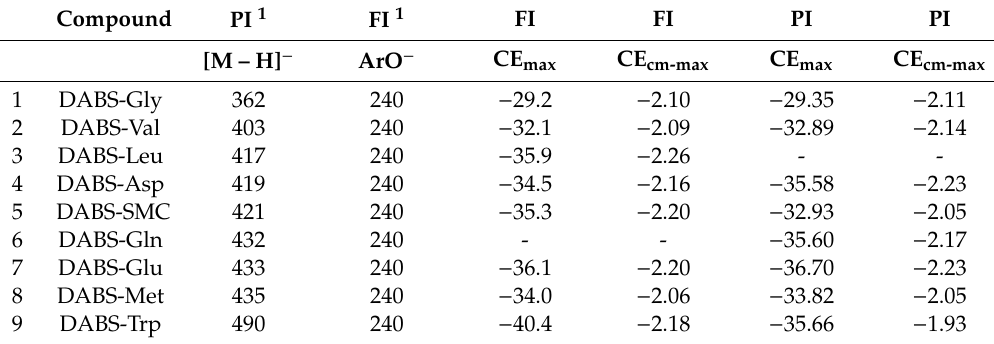
Table 1. Collection of CE max and corresponding CE cm-max measured for nine synthetic dabsylated alpha amino